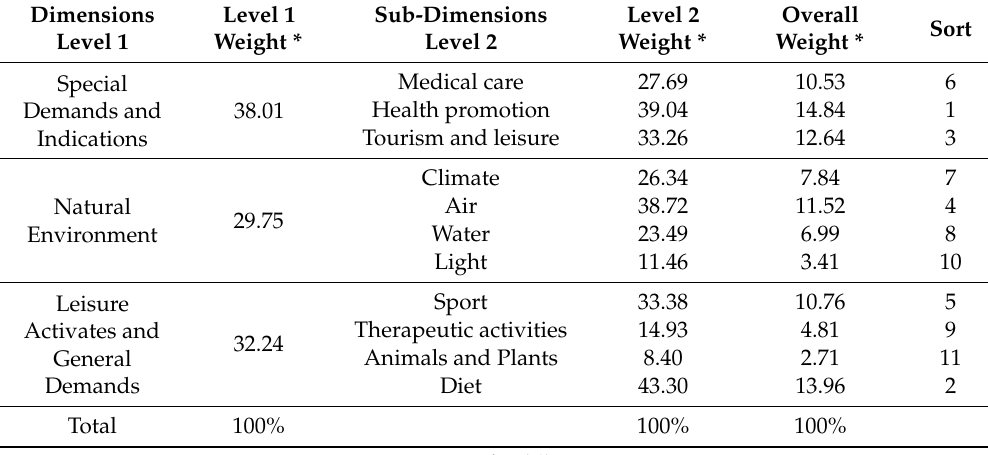
Table 1. Overall assessment of health tourism